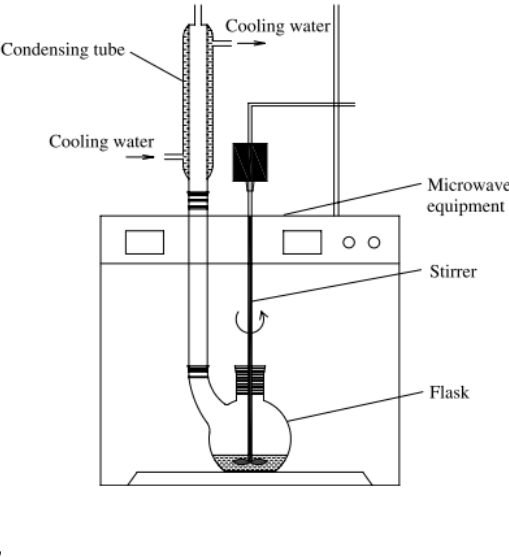
Figure 3. Schematic diagram of the microwave